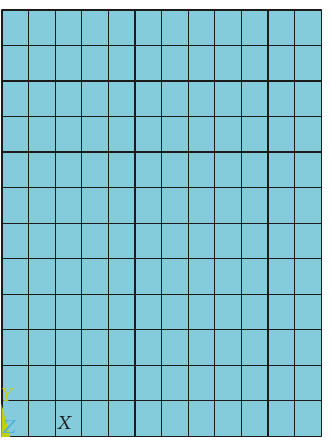
Figure 8: A two-dimensional transient heat conduction model.